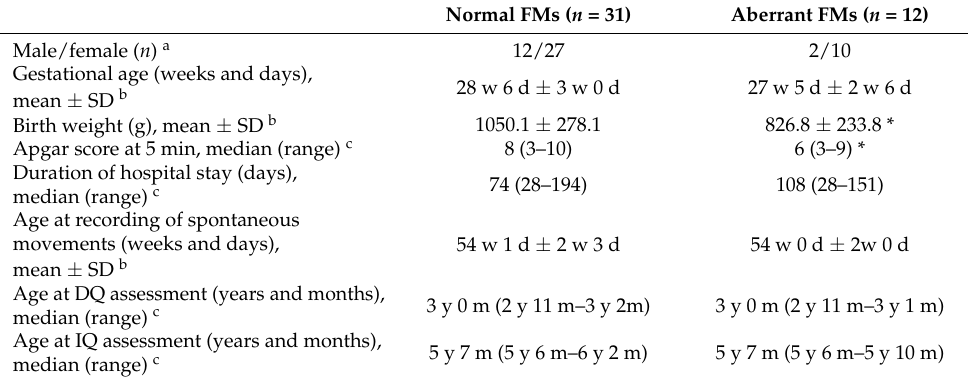
Table 1. Characteristics of participating infants.